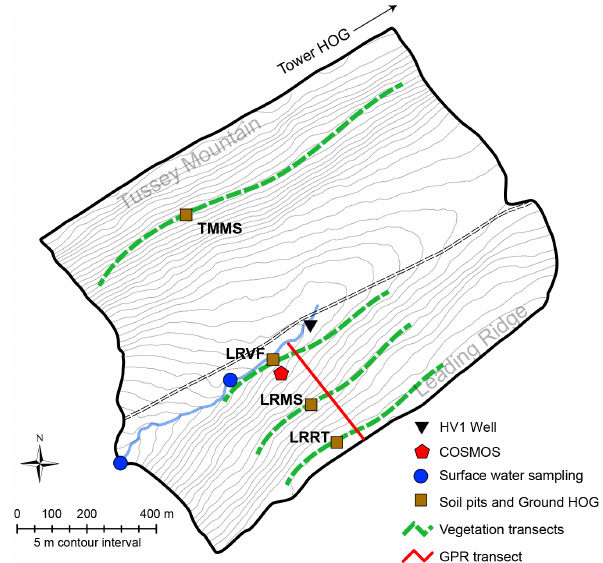
Figure 5. Map showing Garner Run subcatchment (blue line is the stream). Black dashed lines delineate Harry’s Valley Road. The Harry’s Valley well (HV1) is shown along with the location of the COSMOS unit and the outlet weir (blue dot to the southwest). The blue dot to the northeast indicates the approximate range of surface water sampling that is ongoing. Soil pits have been emplaced as shown, along with the Ground HOG deployment. Location of vege- tation and ground-penetrating radar (GPR) transects reported in this paper are also shown. Tower HOG location is along the crest of Tussey Mountain to the northeast of the Garner Run subcatchment (Fig.